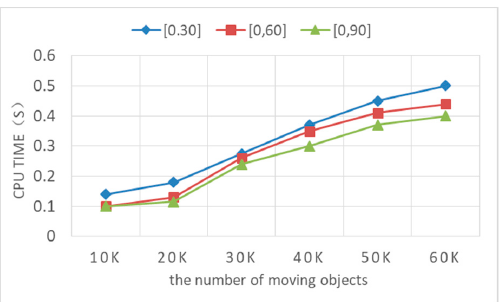
Figure 11. Effect of K value on Performance. Figure 9. E ff ect of K value on Performance. ISPRS Int. J. Geo-Inf. 2019 , 8 , x FOR PEER REVIEW